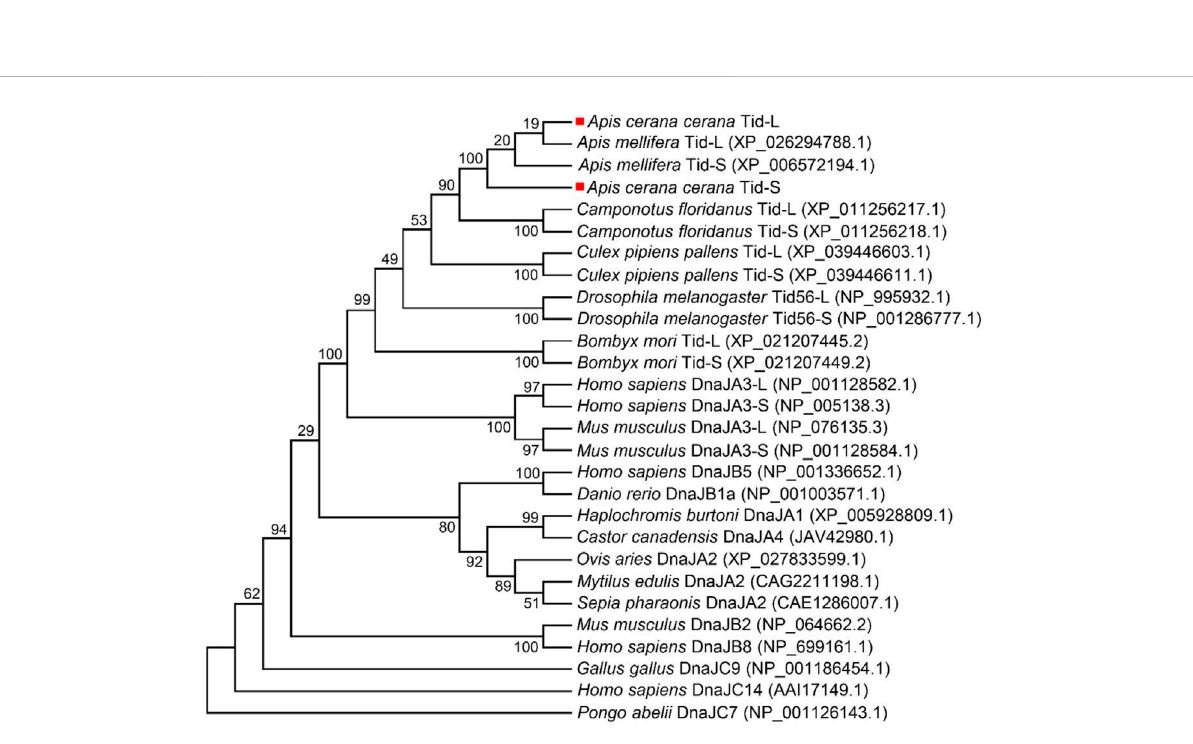
FIGURE 2 Phylogenetic analysis of Tid proteins from various animals. AccTid-L and AccTid-S are indicated with red squares. -L: long isoform. -S: short